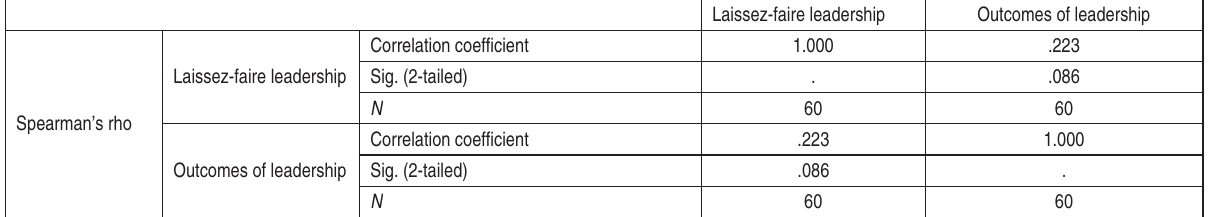
Table 8. Correlations between laissez-faire leadership and outcomes of leadership